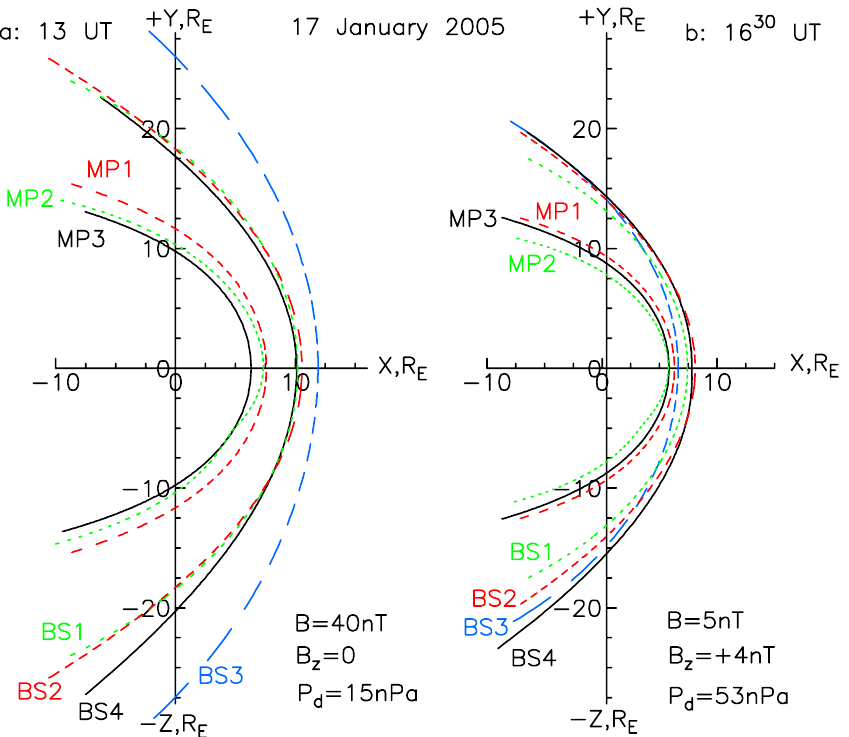
Fig. 9. Magnetopause and bow shock profiles provided by the three magnetopause and four bow shock models when using the solar wind parameters measured (a) at 13:00UT and (b) at 16:30UT on 17 January 2005: MP1 (Shue et al., 1998) in dashed red, MP2 (Lin et al., 2010) in dotted green, and MP3 (new model) in continuous black line; BS1 (Farris et al., 1991; Farris and Russell, 1994) in dotted green, BS2 (Cairns et al., 1995; Farris and Russell, 1994) in dashed red, BS3 (Jerab et al., 2005) in dashed blue, and BS4 (Verigin et al., 2001a,b, 2003) in continuous black line. Vertical axis pointing upwards: + Y GSE direction; vertical axis pointing downwards: − Z GSE direction (MP2 model is in GSM